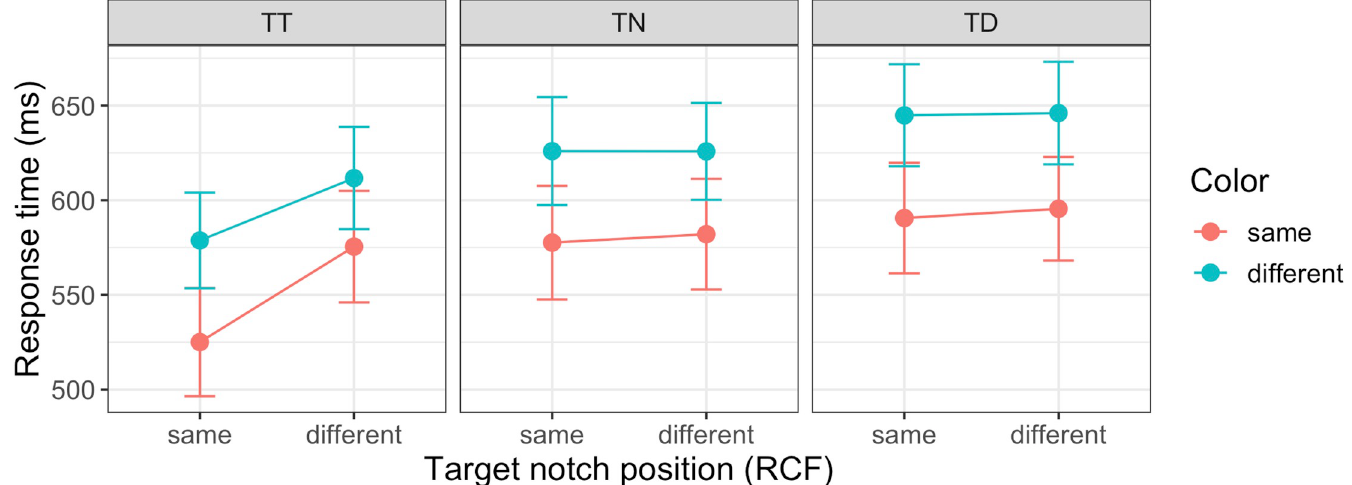
Fig 3. Response times. Mean response times for repeated/non-repeated color, target notch ‘orientation’ (the response- critical feature), and for the different positional transitions: target at previous target position (TT), target at previously neutral (i.e., empty) position (TN), and target at previous distractor position (TD). Error bars show the 95% confidence intervals. RCF: response-critical